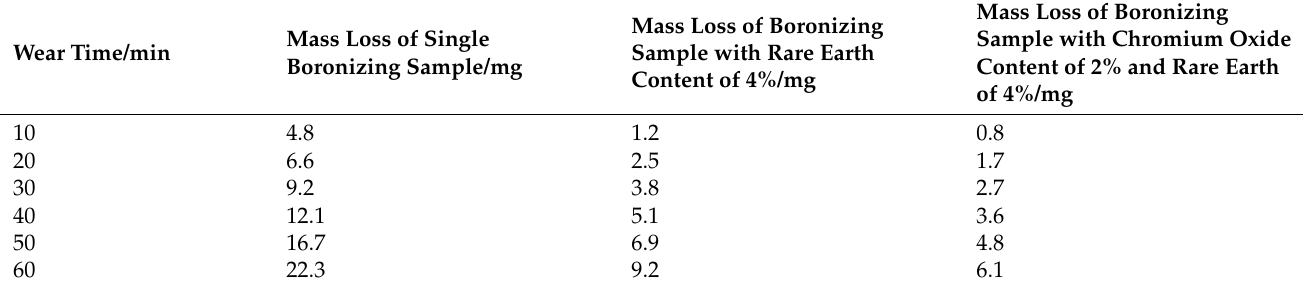
Table 9. Mass loss of boronizing samples for the three